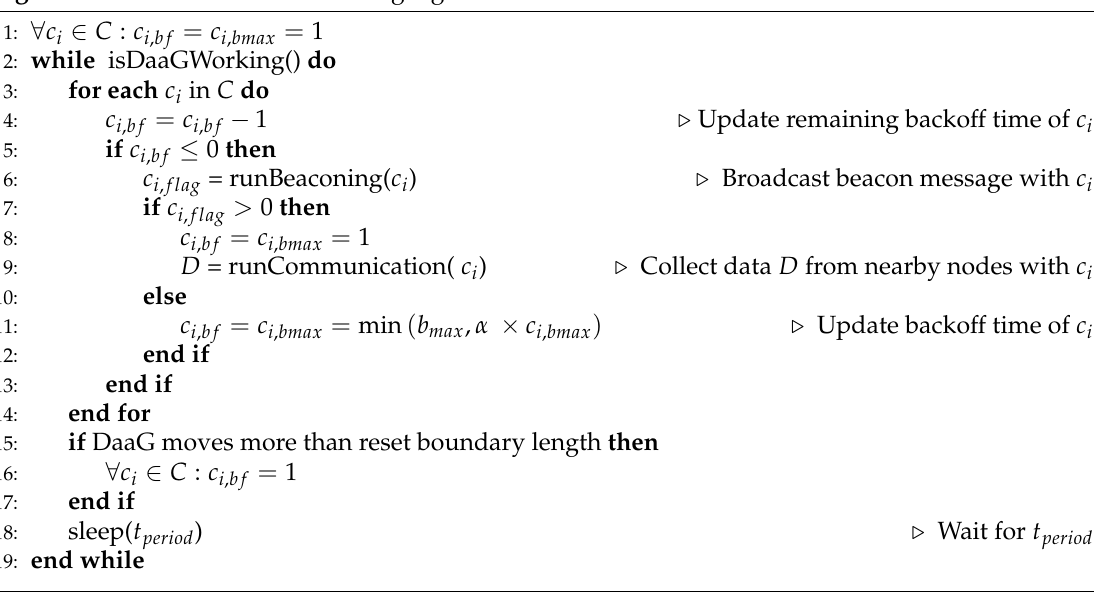
Algorithm 1 Backoff-based beaconing